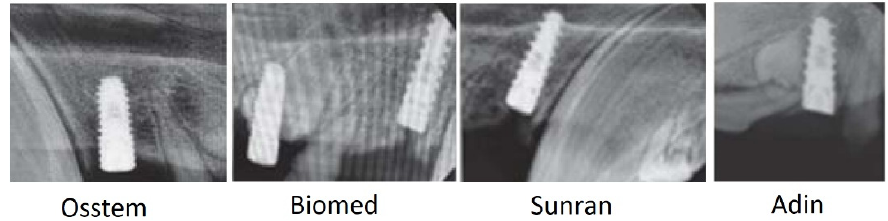
Figure 1. X-ray sampling of targeted radiography of the jaw bones of minipigs with different implantation systems one month after the installation of implants.